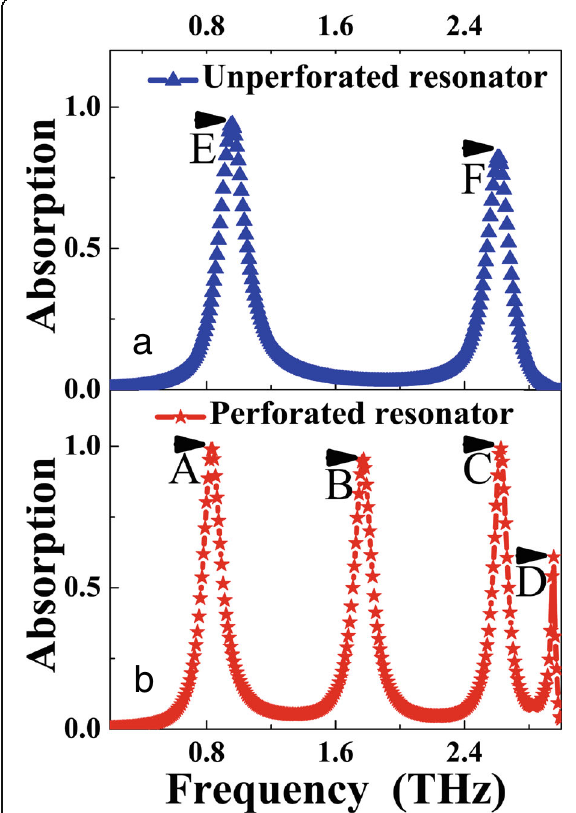
Fig. 3 a and b are respectively the absorption performance of the unperforated and perforated rectangular light